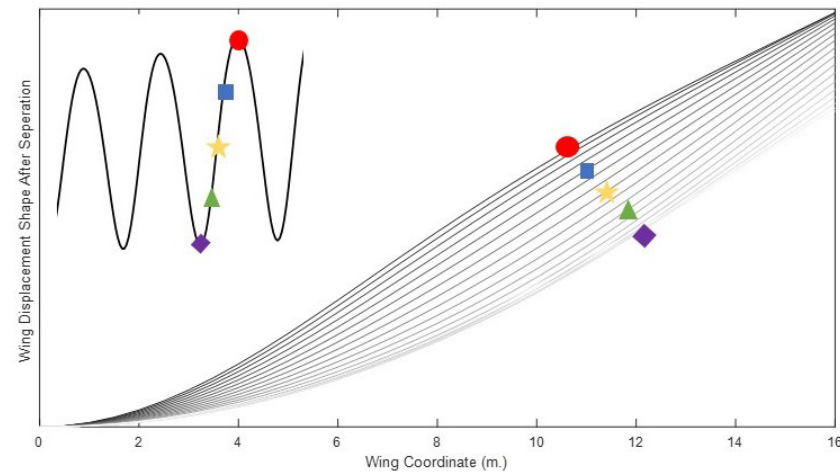
Figure 9. Wing oscillatory motion identified at different time steps within the same